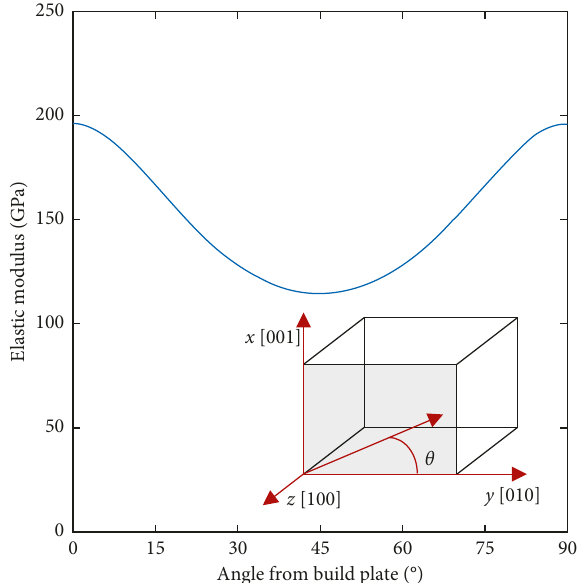
Figure 16: Elastic modulus is according to Equation (10) with a value for E < 100 > > E < 111 > as measured with DIC for set 1. Inset: {100} plane in a FCC crystal with xyz and corresponding (hkl) coordinates.